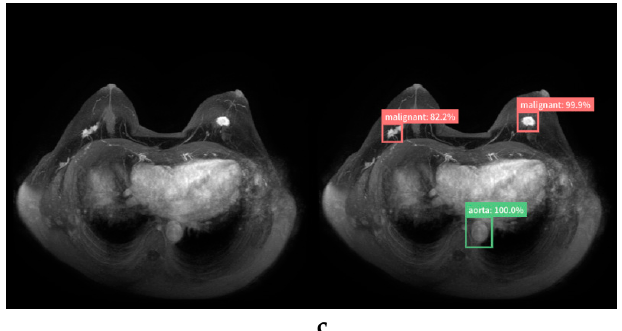
Figure 5. True-negative ( a ) and true-positive cases ( b , c ) diagnosed by the AI system (left, original image; right, image diagnosed by AI system). The AI system did not respond to normal breasts ( a ). The AI system correctly detected and diagnosed invasive ductal carcinoma (IDC) of the right breast ( b ) and invasive ductal carcinoma of bilateral breasts ( c ).